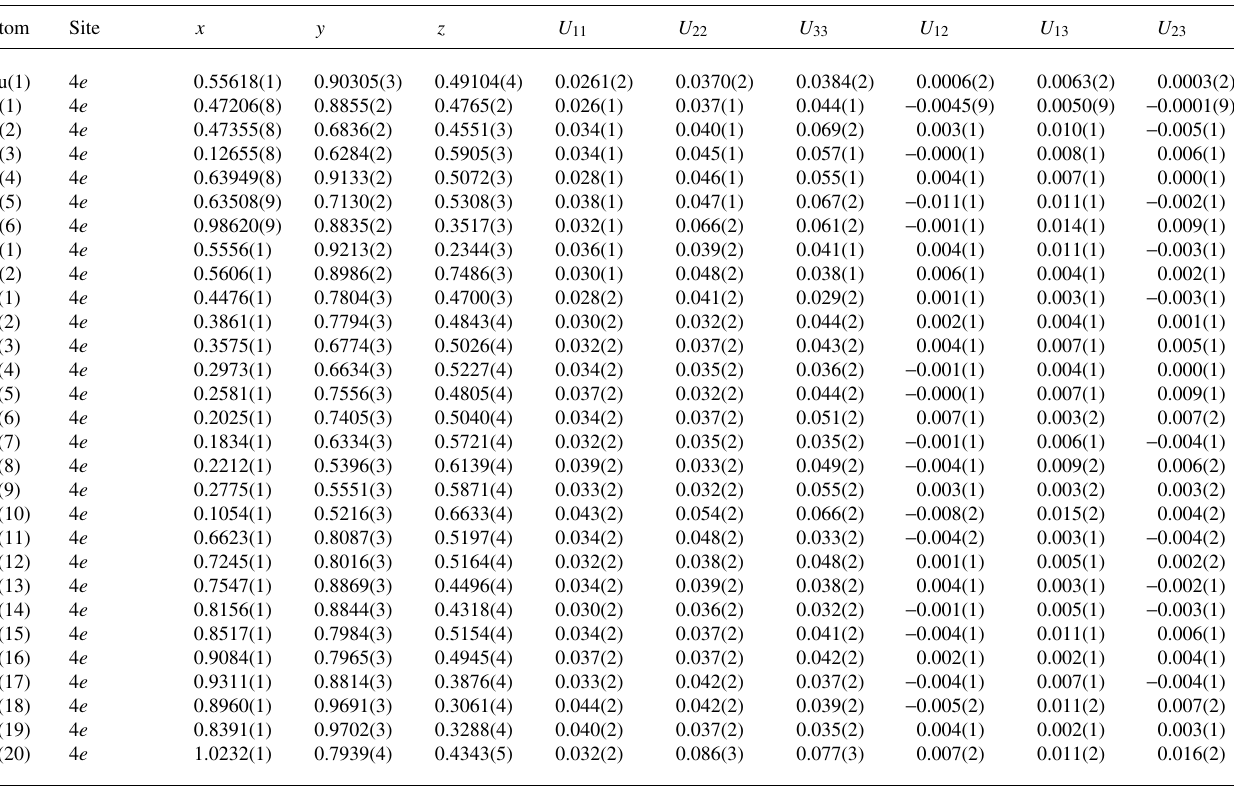
Table 3. Atomic coordinates and displacement parameters (in Å 2 ) .